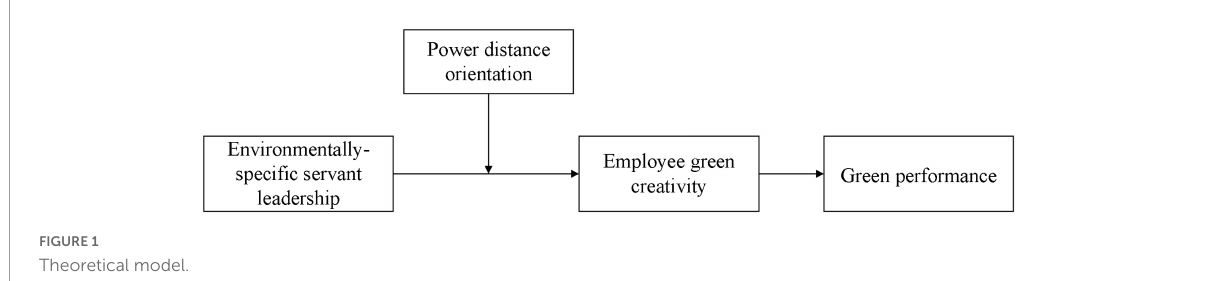
FIGURE1 Theoretical